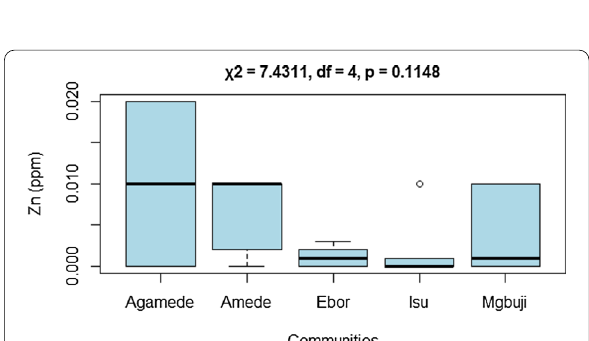
Fig. 8 Comparison of bioaccumulation of Zn in Achatina spp amongst sampled